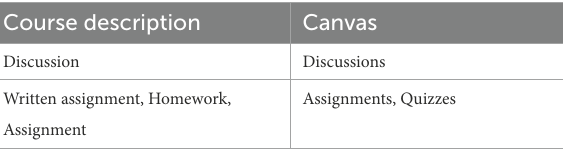
TABLE 3 Learning activities listed in course descriptions matched with Canvas activity features.